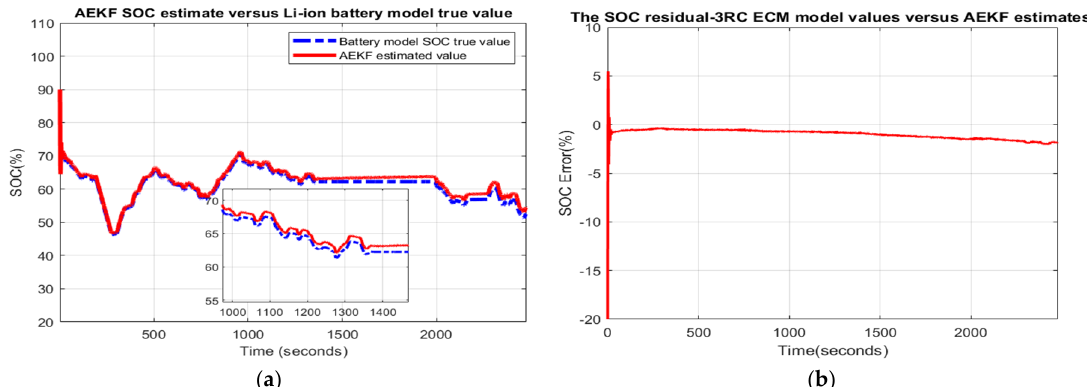
Figure 2. Robustness to simultaneous changes, SOCini = 1, Qnom = 4.2 Ah (ageing effects); ( a ) AEKF SOC value versus battery model true value; ( b ) SOC residual. Batteries 2020 , 6 , x FOR PEER REVIEW